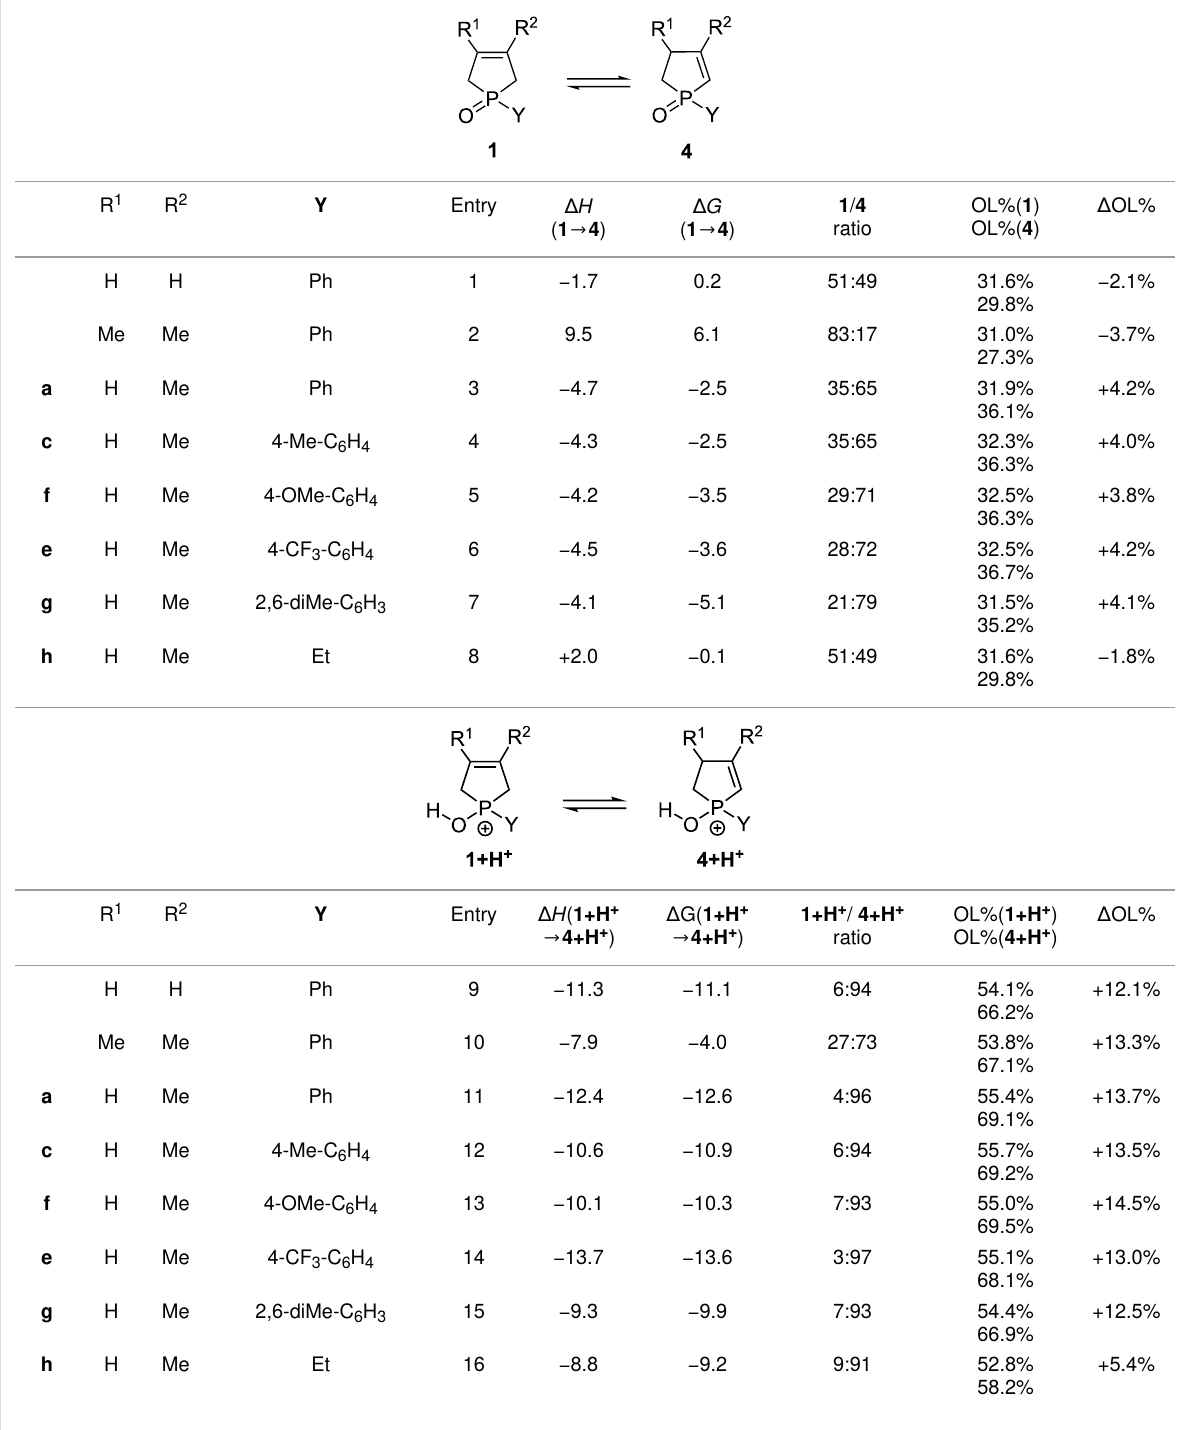
Table 5: Reaction enthalpies ( Δ H in kJ mol − 1 ) of the isomerization processes of 1 → 4 and ( 1+H + ) → ( 4+H + ) at MP2/6-311G++(2d,2p) level of theory. Their calculated olefinicity values (OL%) are also given in percentages at the same level of